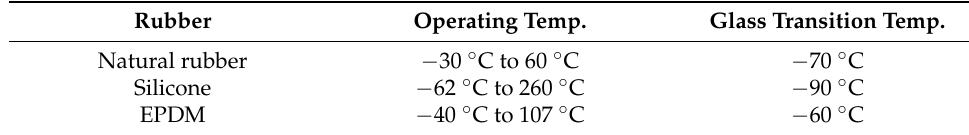
Table 1. Operating temperatures of the selected rubbers.